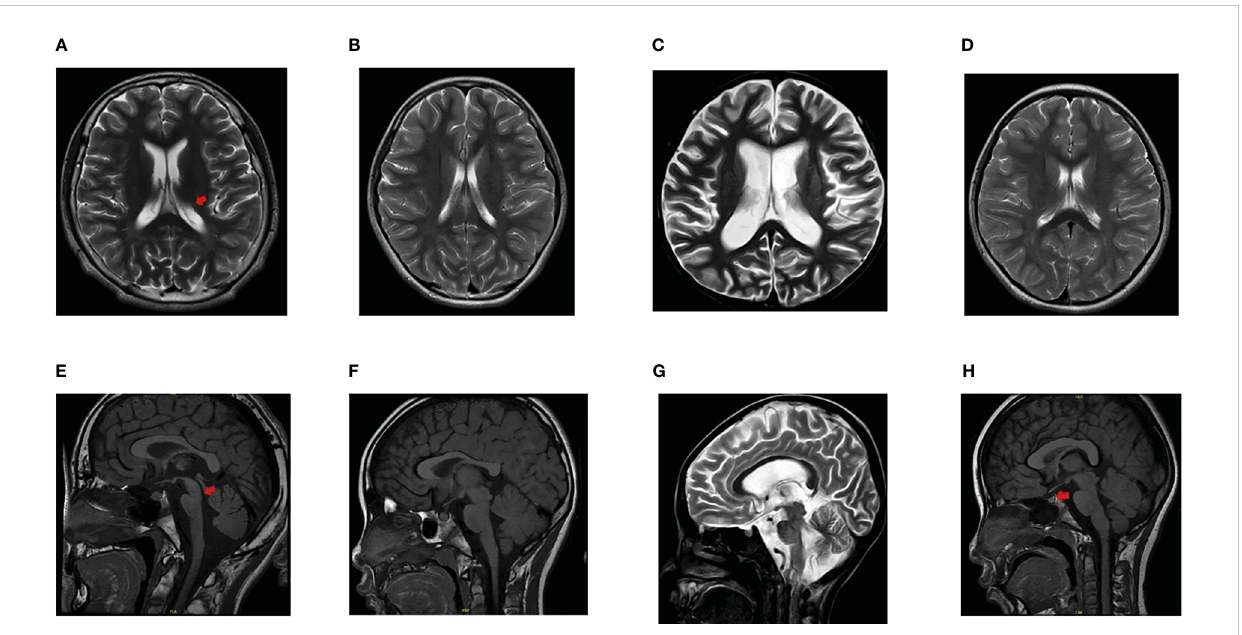
FIGURE 1 Findings of brain MRI in patients. (A, E) The ventricular system was enlarged (arrowhead in A), the sulci and cisterns were widened, the brain stem morphology was poor (arrowhead in E), and lacked a clear high signal indicating the neurohypophysis in patient 1. (B, F) The MRI fi nding presented as an abnormally small neurohypophysis without encephalatrophy in patient 2. (C, G) Atrophic changes of the brain was found and lacked a clear high signal indicating the neurohypophysis in patient 5. (D, H) No signs of brain atrophy and a normal high signal of neurohypophysis (arrowhead in H) were displayed in patient